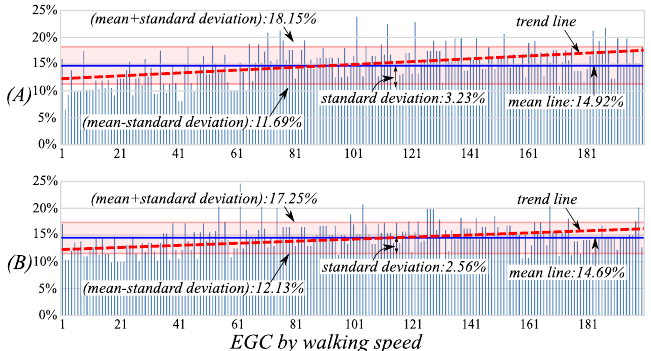
Figure 9. The percentage distributions of the mid-LSw ( A ) and mid-RSw ( B ) in the cycle during the EGC. The walking speeds of the EGC are gradually increasing along the horizontal axes.